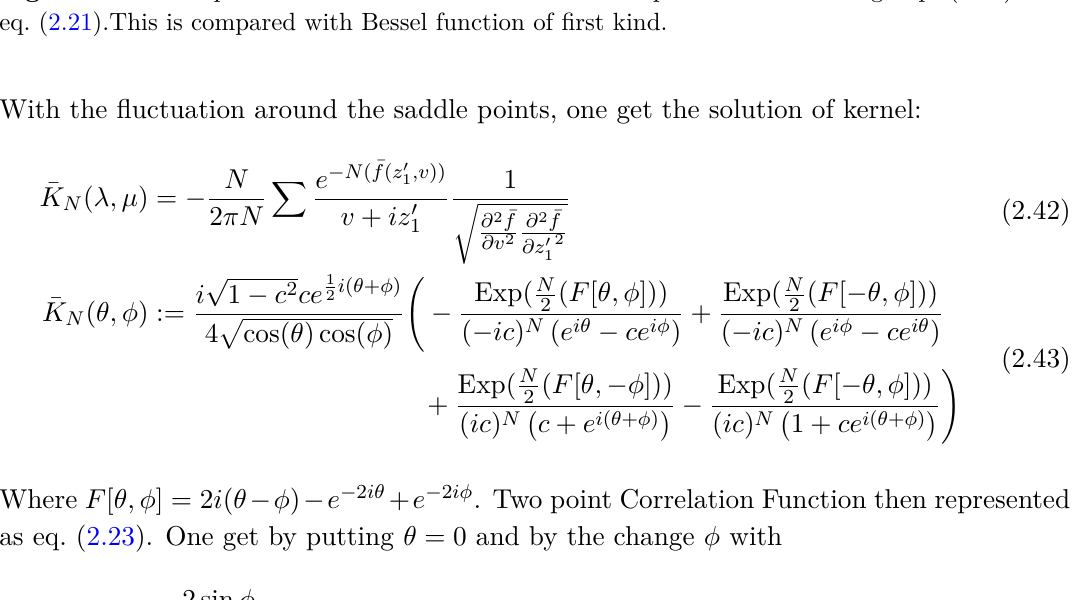
Figure 3 . Two-point correlation function connected part behavior using eq. (2.44) and eq. (2.21).This is compared with Bessel function of first